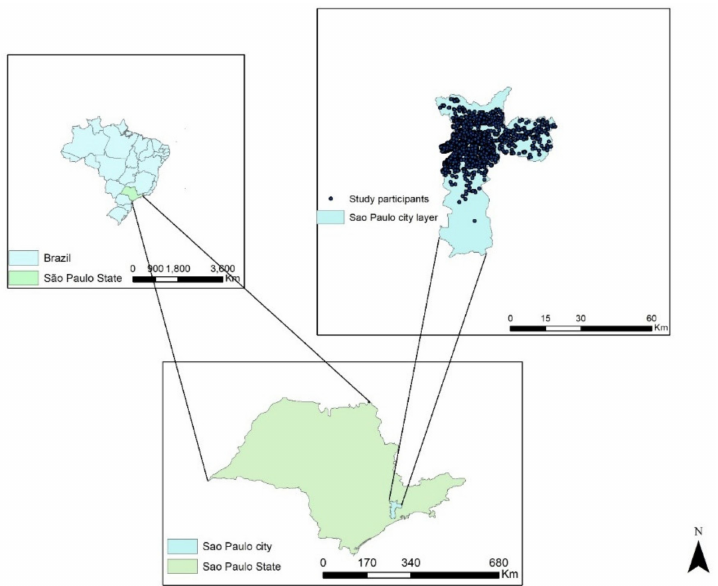
Figure 1. S ã o Paulo city layer, Brazil and the distribution of the Longitudinal Study of Adult Health (ELSA-BRASIL) participants within the city ( n = 3418).